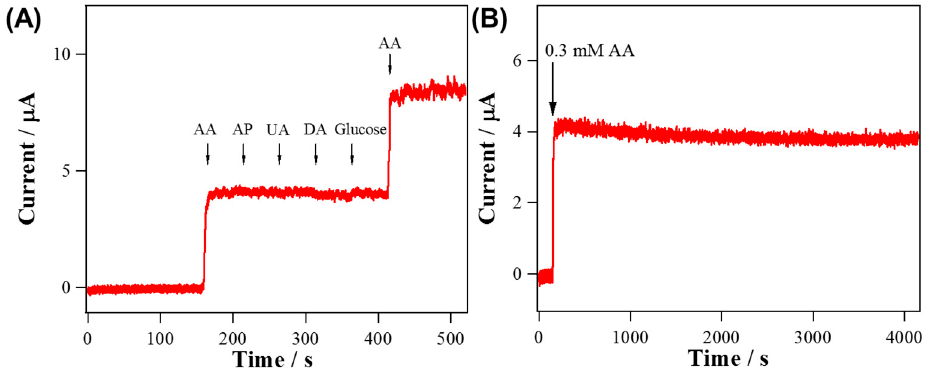
Figure 6. ( A ) Amperometric response of RuO 2 NRs-WO 3 NFs to sequential additions of 0.3 mM AA, 0.1 mM AP, 0.1 mM UA, 0.1 μ M DA, 5 mM glucose and 0.6 mM AA to 0.1 M PBS (pH 7.4) with E app = 0 V (vs. S.C.E.). ( B ) Continuous amperometric response of RuO 2 NRs-WO 3 NFs to 0.3 mM AA in 0.1 M PBS during 4200 s with E app = 0 V (vs. S.C.E.).